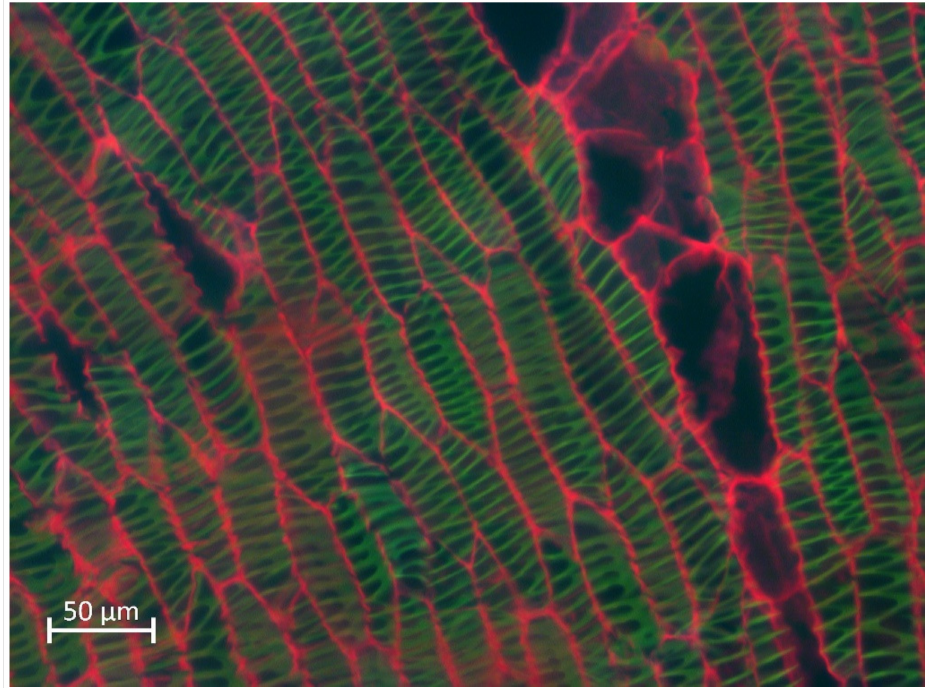
Figure 2. Epifluorescence image from a Lophocereus marginatus secondary xylem stained with safranin- fast green, excited at 365 nm (blue), 470 nm (green), and 546 nm (red) at the same time. Scale bar: 20 µ m. Image taken from personal